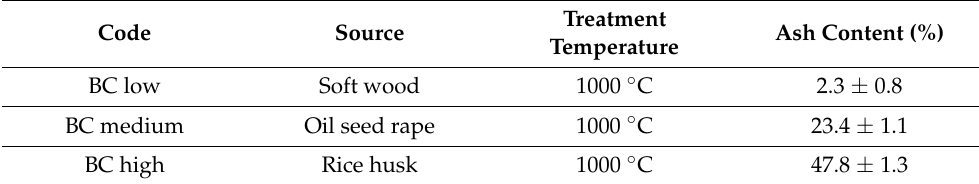
Table 1. List of codes used to identify biochar